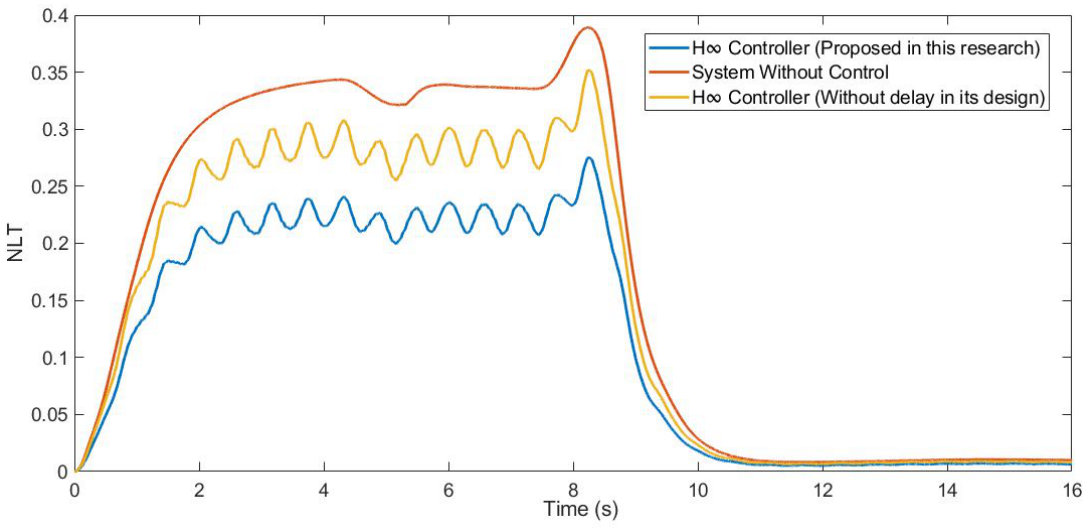
Figure 13. NLT of rear axle for test 1: Roundabout at 30 km/h.